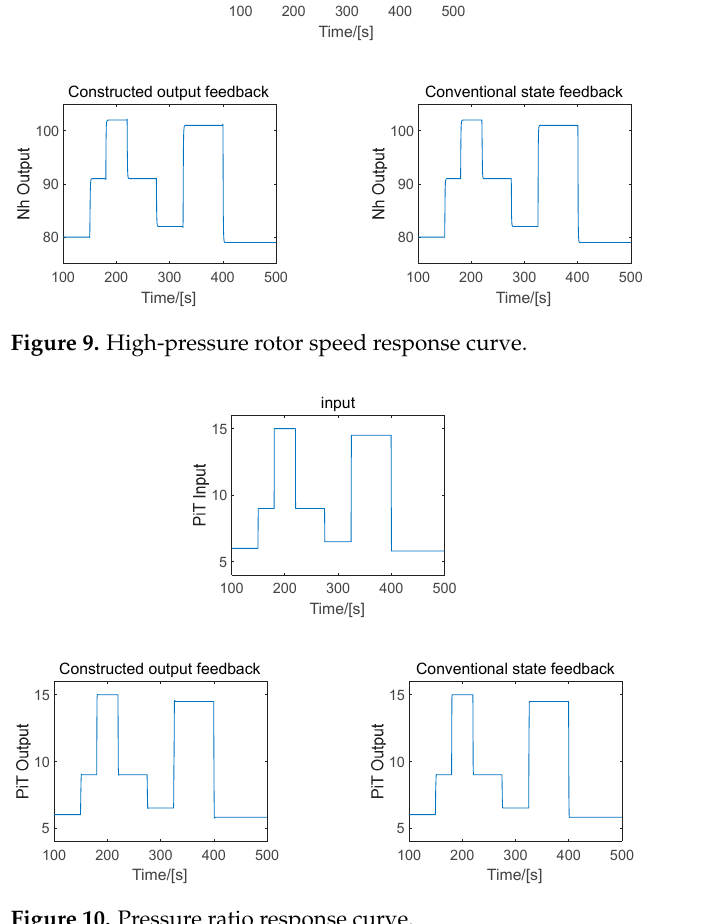
Figure 10. Pressure ratio response curve.